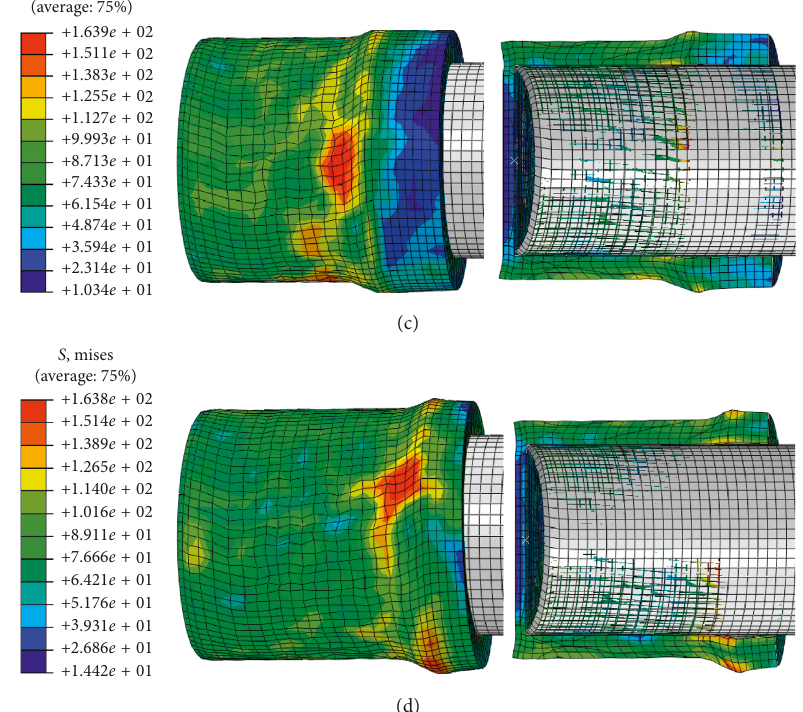
Figure 7: First-pass equivalent stress distribution. (a) 25%. (b) 50%. (c) 75%. (d)